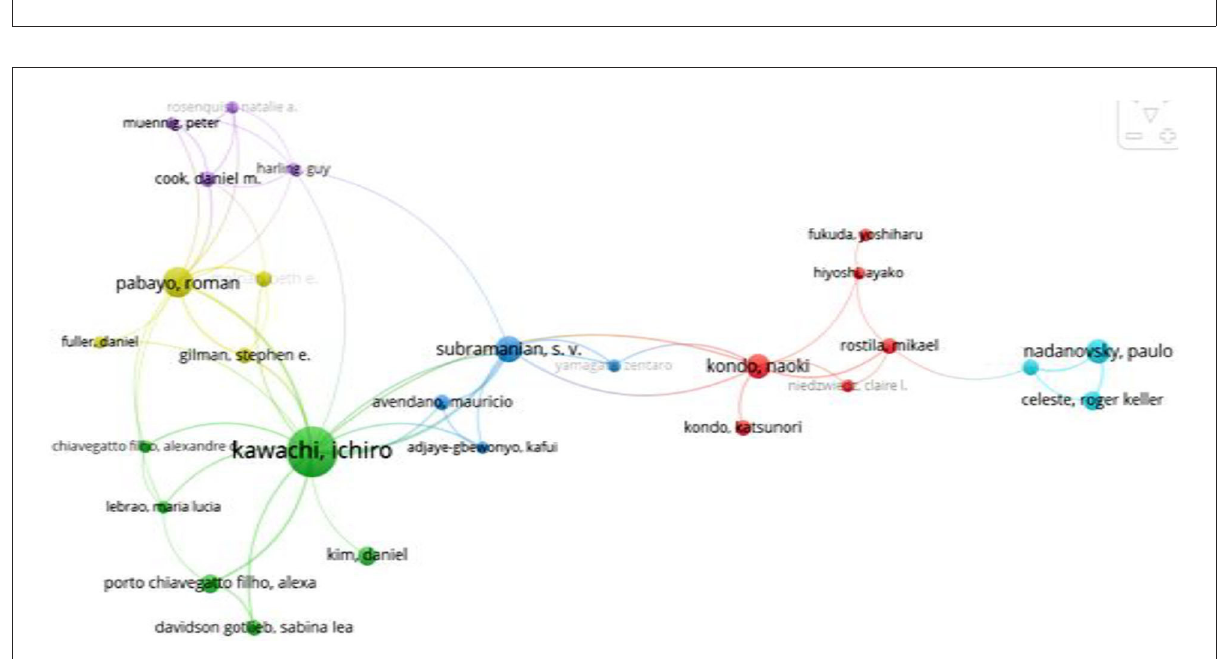
FIGURE6 Collaboration between